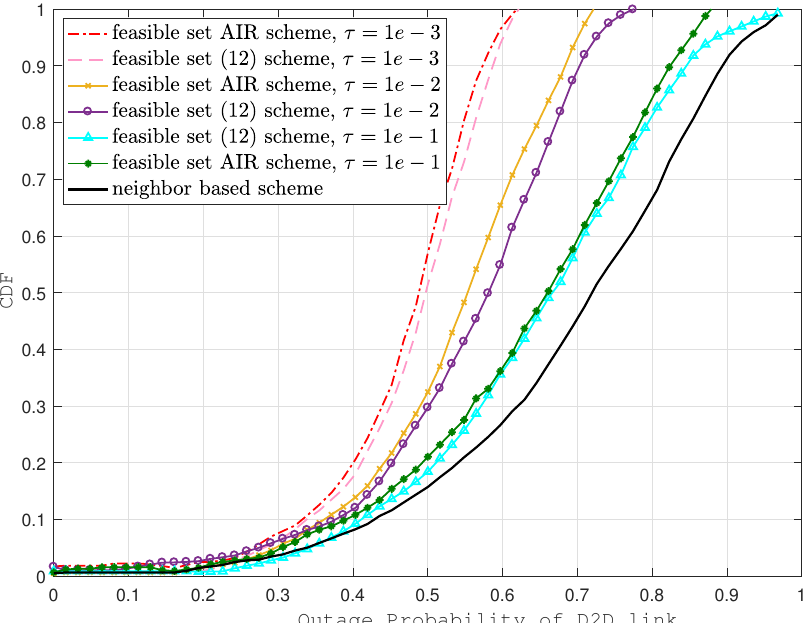
Figure 3. Outage probability of D2D links with different schemes.